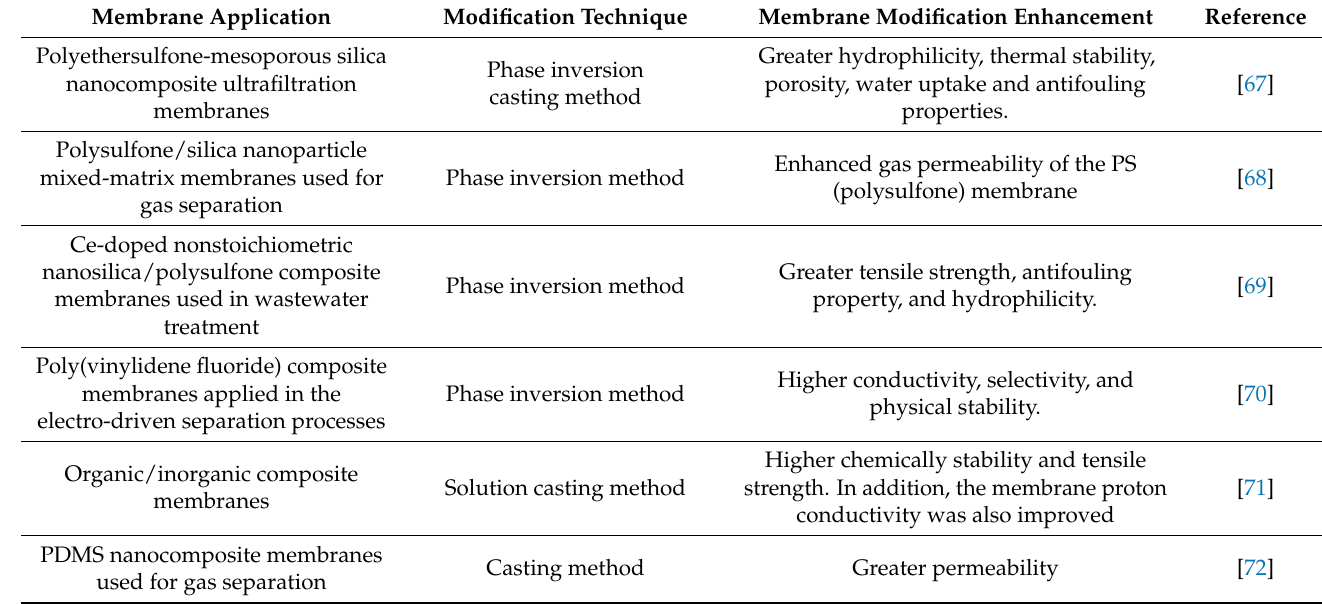
Table 3. A summary of key elements of SiO 2 nanoparticle-based nanocomposite